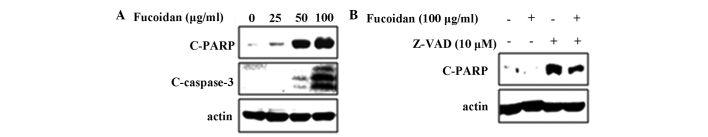
Caspase-mediated apoptosis in MC3 MEC cells. (A) Cleaved PARP and caspase 3 were detected in MC3 MEC cells treated with fucoidan by western blot analysis and actin was used as the loading control. (B) A pan caspase inhibitor (zVAD-fmk) was used to evaluate the involvement of caspase 3 in fucoidan-induced apoptosis. MEC, mucoepidermoid carcinoma cancer; PARP, poly ADP ribose polymerase.